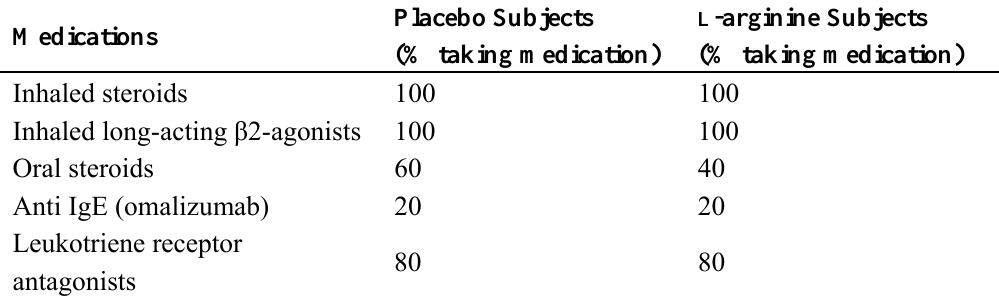
Table 2. Baseline study participant asthma medications at study